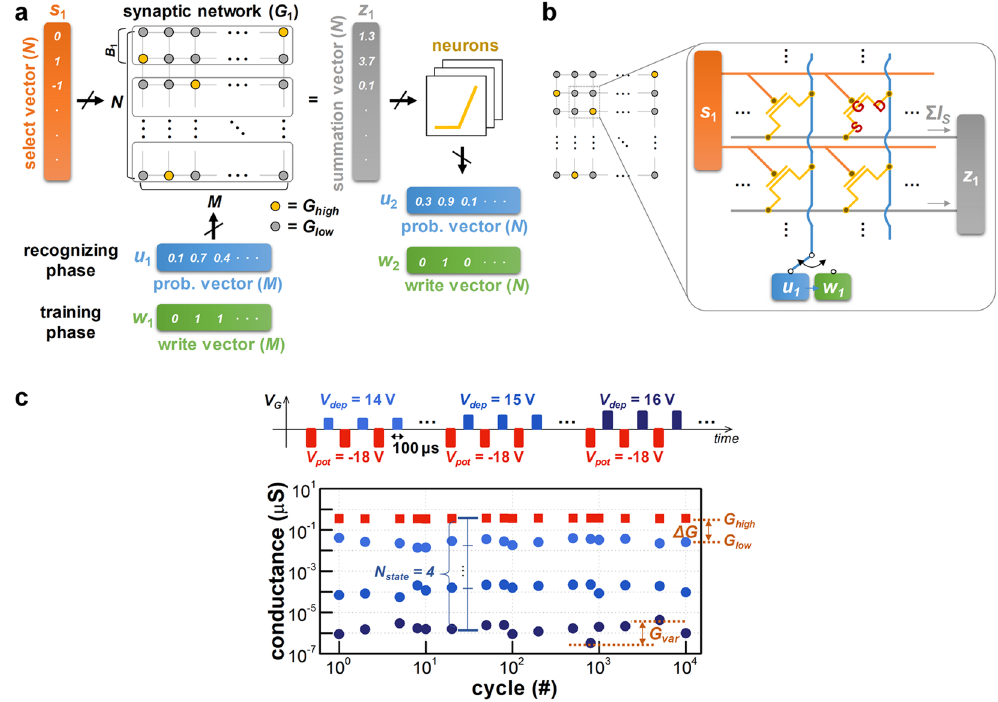
Figure 1. ( a ) The architecture of the binary neural network with M inputs and N outputs. The input image information corresponds to u 1 ( i ) and w 1 ( i ). The vector s 1 ( i ) enables supervised training by selecting a specific row, and z 1 ( i ) is the output of the network. ( b ) The schematic of a synaptic transistor array, where s 1 ( i ) involves V G , and either u 1 ( i ) or w 1 ( i ) involves V D . The integration of I S along a row corresponds to z 1 ( i ). ( c ) Schematics of the applied pulse trains used to characterize the channel conductance modulation property of the GAA silicon nanosheet transistor. Each pulse train consists of potentiation and depression pulses applied to the gate ( V pot and V dep for 100 μ s). Control of the V pot level contributes to the different conductance-switching behaviors of N state , Δ G , and G var